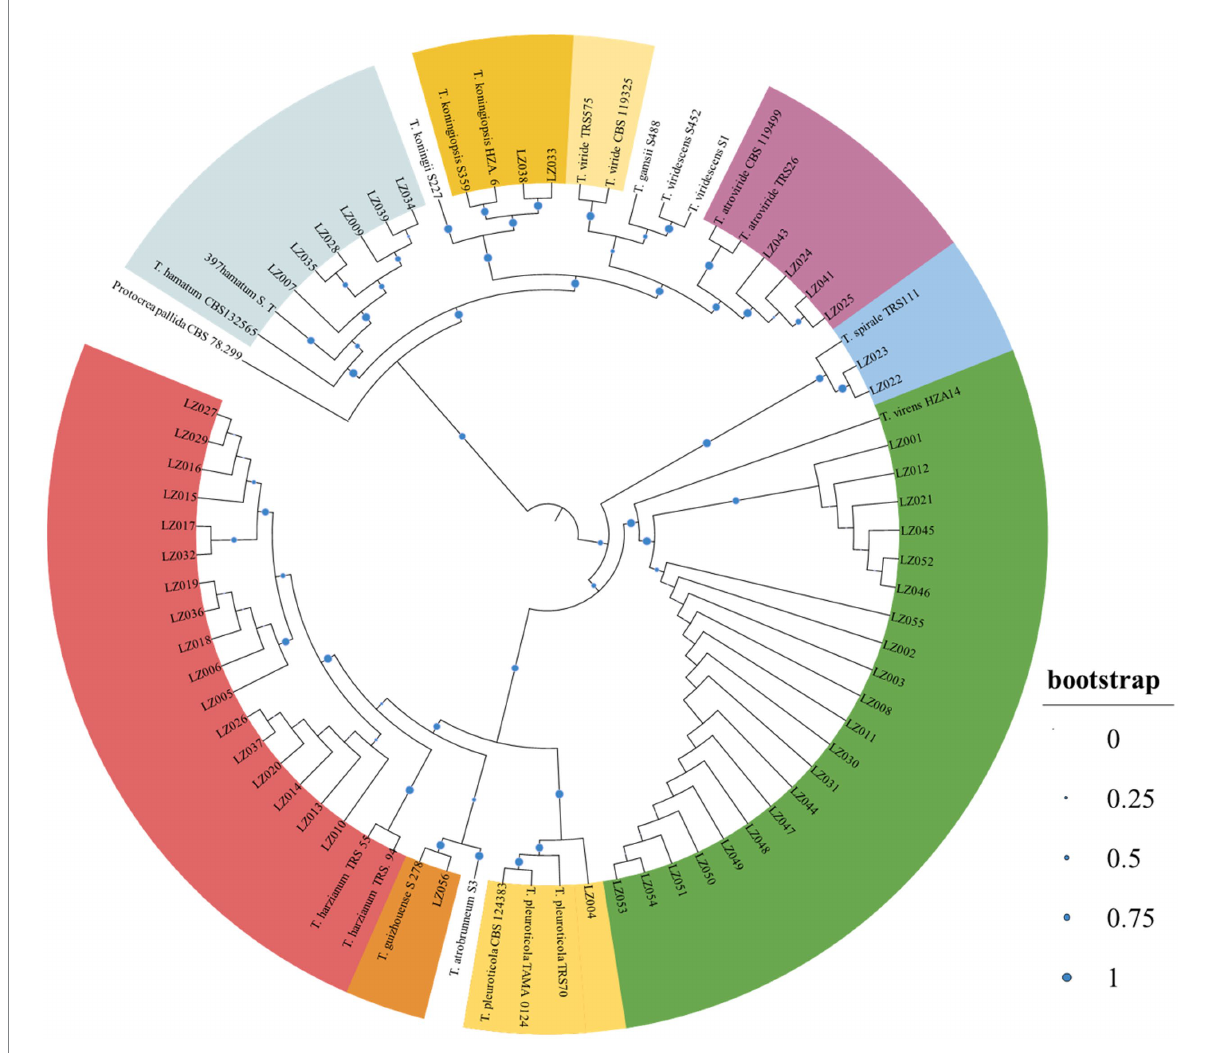
FIGURE 2 Phylogenetic tree of the representative Trichoderma isolates using the maximum-likelihood method based on the condensed tef-1 α and rpb2 . The tree was constructed using Mega 7.0 with 1,000 bootstrap replications condensed with a 70% cut-off value and viewed on iTOL. Protocrea pallid a CBS 78.299 was used as an